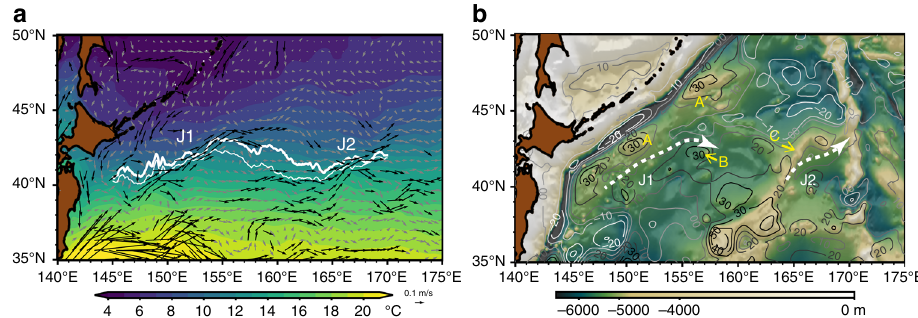
Fig. 1 Quasi-stationary jets in the Subarctic Frontal Zone. a Annual mean SST (shade), surface current (arrows) and SST front position (white solid lines) derived from the JCOPE2 ocean reanalysis (see Methods). Surface currents faster than 0.1 ms − 1 are denoted by black arrows, while slower than 0.1 ms − 1 by gray arrows. As for the SST front position, it is represented by the latitude Φ ( x , t ) where the meridional gradient of SST is maximum in the region 145° E – 170°E, 35°N – 47°N, derived from JCOPE2. Here, Φ ( x , t ) is decomposed to Φ x ; t ð Þ (cid:2) Φ ð x Þ þ EOF 1 ð x Þ (cid:3) OEI ð t Þ , where Φ ð x Þ is the temporal mean position, and EOF1( x ) and OEI( t ) denote the 1st mode empirical orthogonal function (EOF) and its time coef fi cient, respectively. OEI( t ) is normalized so that its standard deviation σ to be unity. White solid lines denote Φ ð x Þ þ EOF1 ð x Þ (cid:3) σ , where σ = 0 (thin line) and σ = 1 (thick line). b Barotropic streamfunction (contours, ×10 6 m 3 s − 1 ) and bottom topography (shades). Barotropic streamfunction is obtained from depth-integrated transport using horizontal velocity fi eld of JCOPE2 reanalysis. Black (light blue) contours denote the positive (negative) value in terms of the streamfunction. The bottom topography is based on ETOPO5, in which bathymetry between 5500 m and 5000 m is emphasized. A , A ′ , B , and C denote the ocean- fl oor rises that are paid attention in this paper. J1 and J2 are indicated by dashed lines with